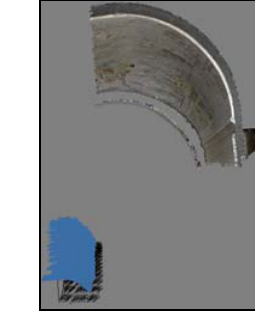
Figure 13 – DPC right Figure 12 – Photogrammetric first third intrados area DPC left first third area and and camera locations in camera locations in right the left lateral lateral row.